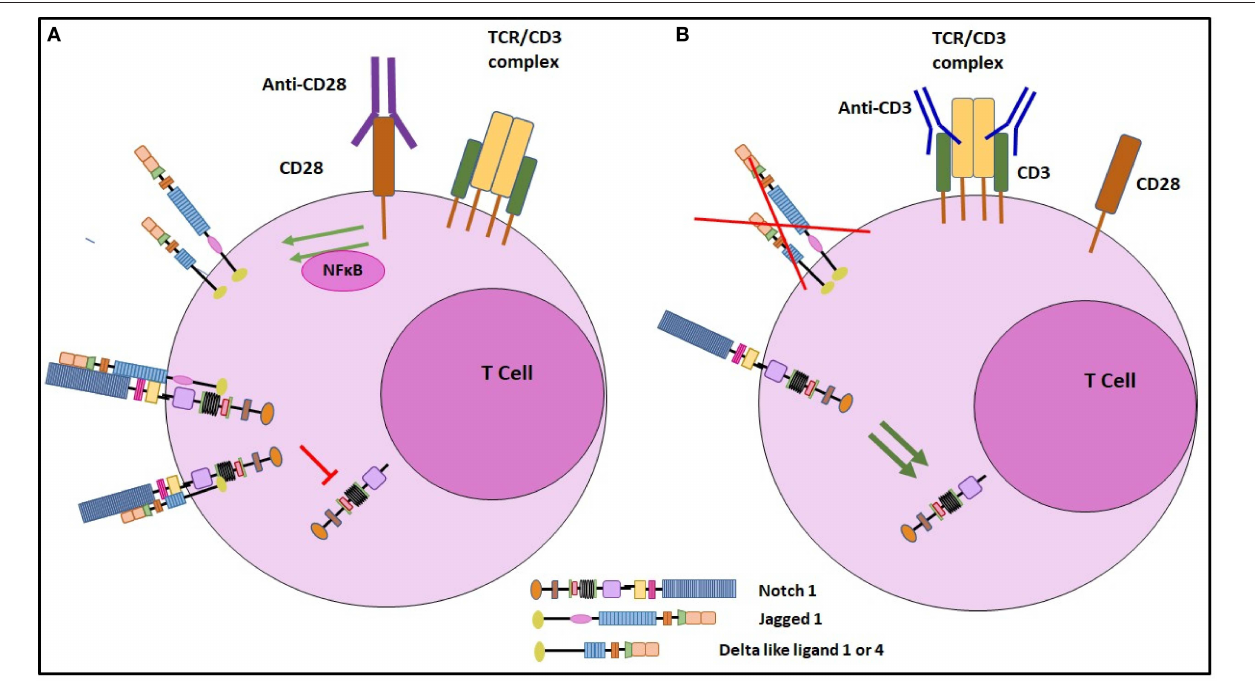
FIGURE 8 | Schematic representation of the regulation of Notch ligand expression on CD4T cells. (A) Signaling through CD28 by engagement with soluble anti CD28 antibody, induces Notch ligand expression on mature CD4T cells. These ligands when cis -interact with Notch receptor, can inhibit cleavage of NICD, the active form of Notch. (B) Signaling through CD3 ε inhibits Notch ligand expression on CD4T cells. By inhibiting Notch ligand expression, CD3 ε signaling prevents cis inhibition and thus induces Notch